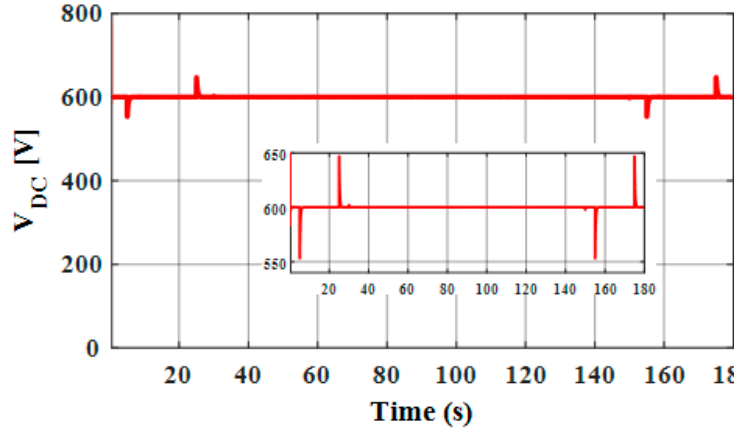
Figure 17. Simulation results for the DC-link voltage.